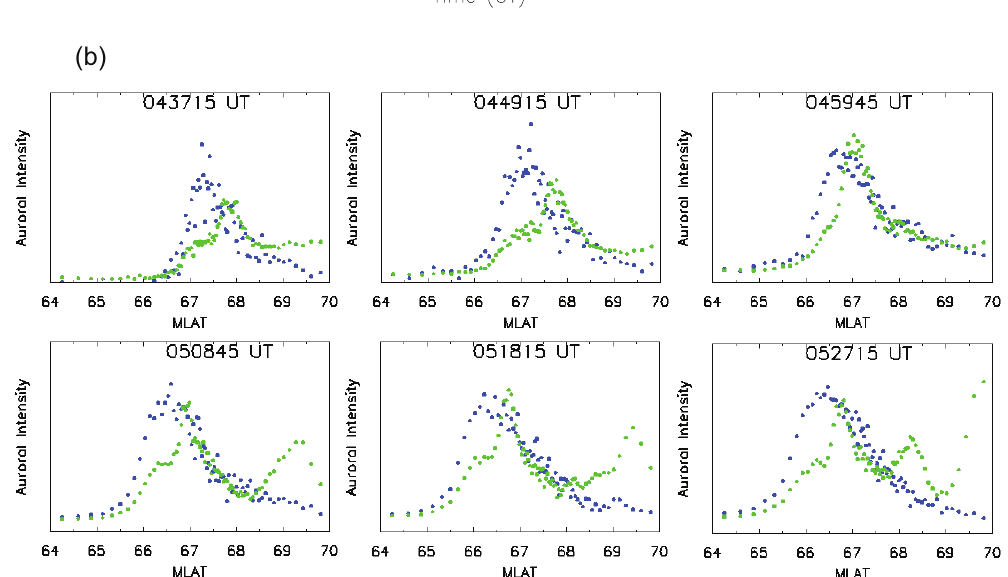
Fig. 6. (a) FSMI MSP observations of the green-line aurora (557.7nm, top panel) and proton aurora (486.1nm, bottom panel). (b) A few example slices showing the latitudinal distribution of 557.7nm (green dots) and 486.1nm (blue dots) auroral intensities. The intensities of two emission lines are scaled differently in the plot, such that only their latitudinal profiles are informative. Each dot represents the measurement from a latitudinal bin of the